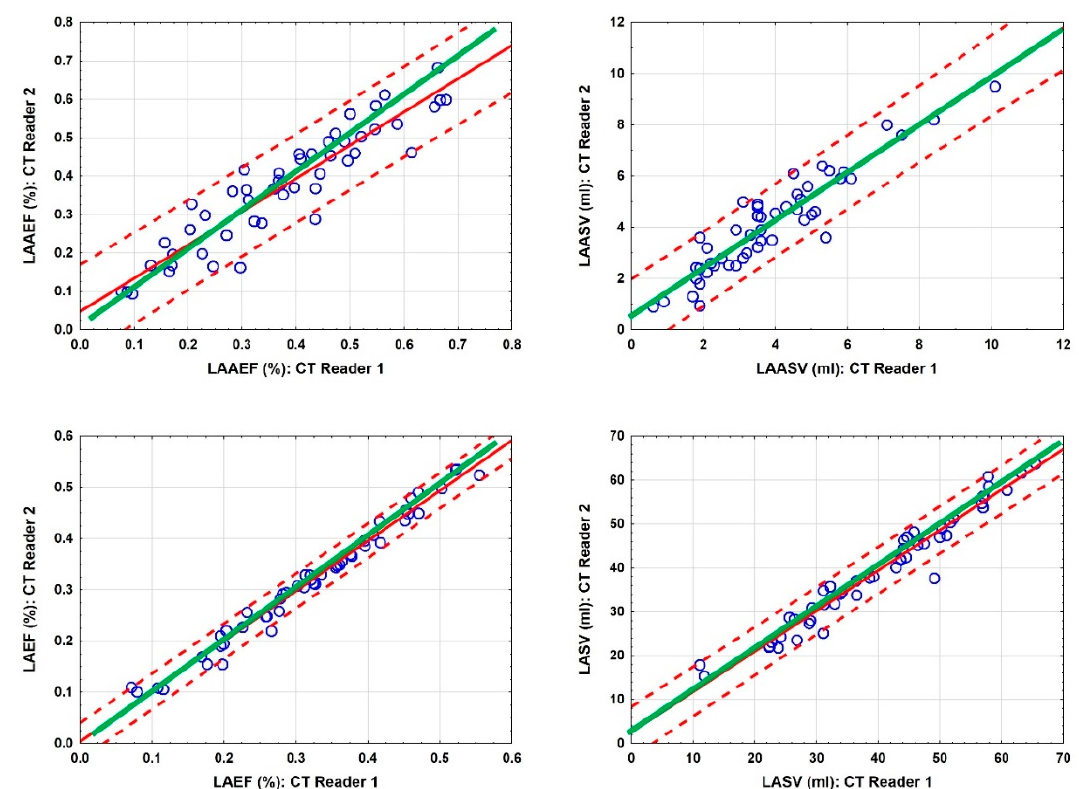
Figure 4. Scatterplots of LAAEF (%), left atrial appendage stroke volume (LAASV) (ml), LAEF (%) and LASV (ml) for CT readers 1 and 2. Green lines indicate the agreement of both readers; red solid lines indicate regression lines with 95% confidence limits (dotted lines).